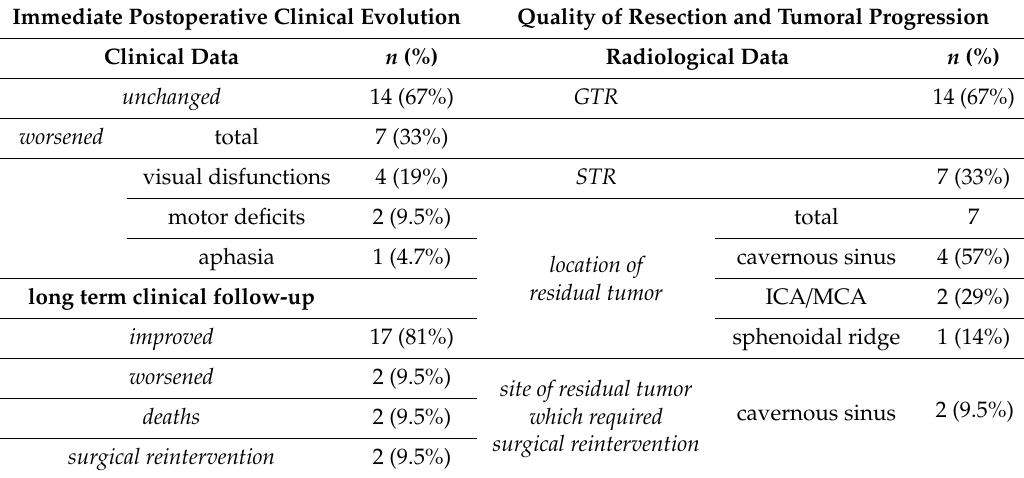
Table 2. Immediate postoperative and long-term